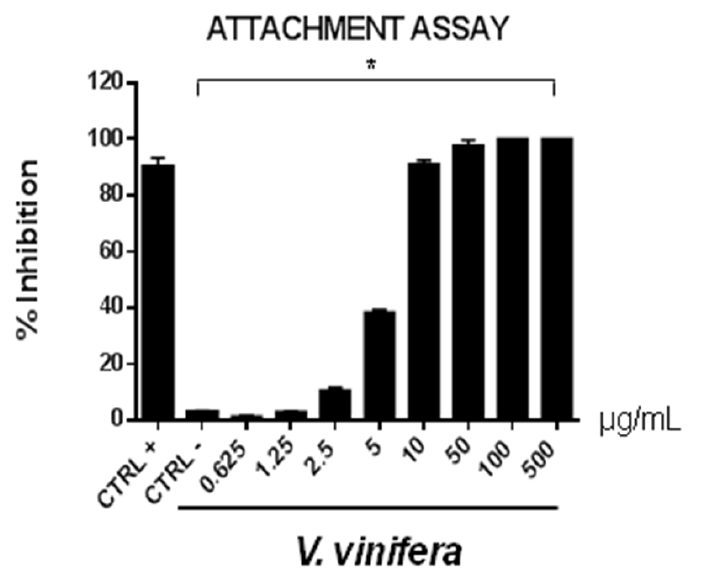
Figure 6. Early viral attachment assay of leaf extract (µg/mL) against SARS-CoV-2. The antiviral activity is expressed as % of inhibition. The results presented were obtained from three independ- ent experiments. Data are mean ± SD. Statistical differences were analyzed via Student’s t -test, a value of p ≤ 0.05 was considered significant, with * p ≤ 0.05. The extract’s inhibitory effects on virus-cell binding event revealed that it was able to block the attachment of both of the viruses into the host cell. It is most likely that leaf extract prevents the binding of viral envelope with the cell membrane and all the subsequent stages of infection by hindering some interacting site inside the viral glycoprotein deputed to the fusion, i.e., HSV-1 glycoprotein B and SARS-CoV-2 spike protein. To validate data obtained by plaque assays, we analyzed the V. vinifera effect on expression genes involved in the viral infection (Figures 7 and 8).